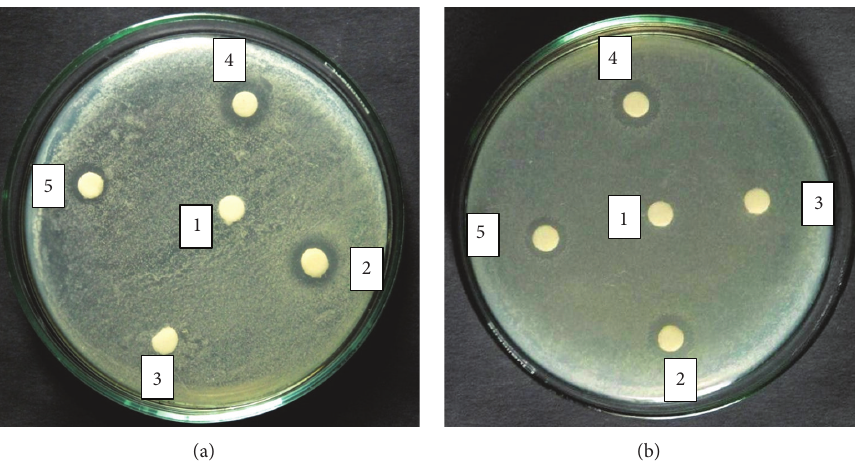
F 8: Plates showing diameters of zones of inhibition of Staphylococcus aureus and E. coli. against distilled water as control (1); Tulsi extract (2); silver nitrate solution (3); AgNPs synthesized by Tulsi extract (4) and water diluted Tulsi extract (dilution factor 1:1)